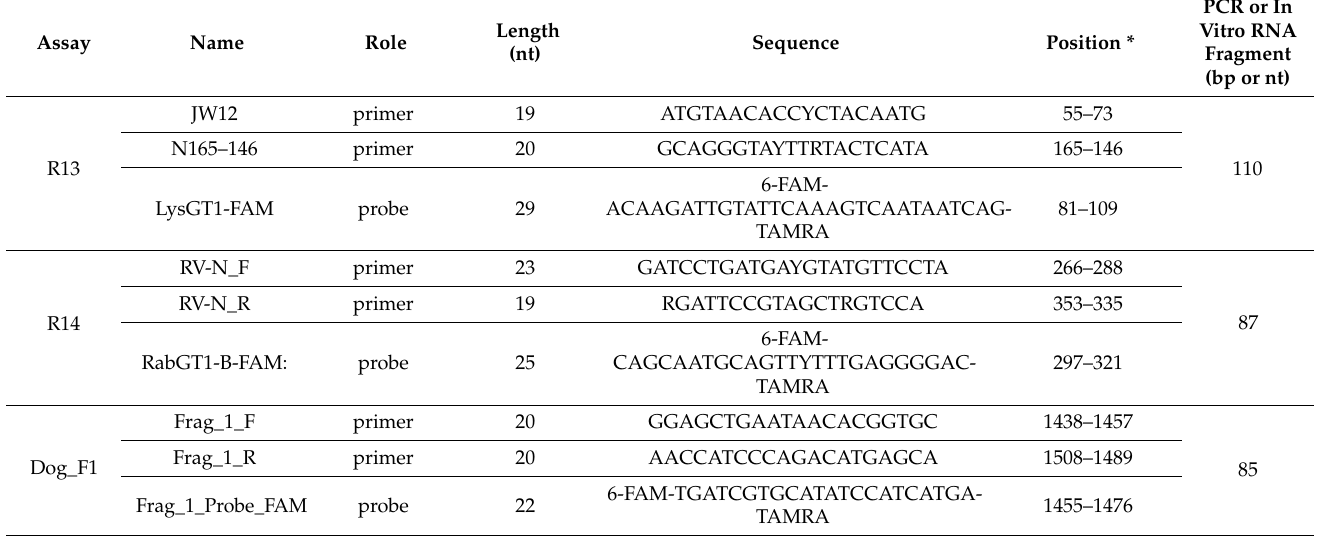
Table 1. Oligonucleotides used in this